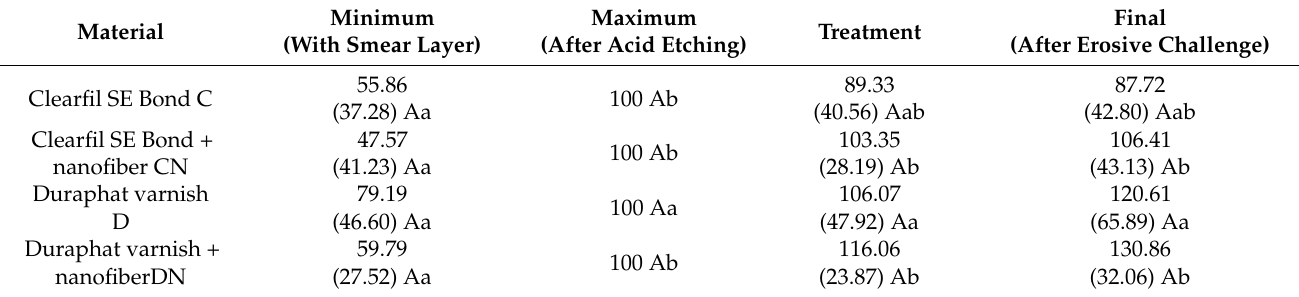
Table 2. Mean and standard deviation of the Lp values (%) of the different treatments under four experimental dentin conditions ( n =